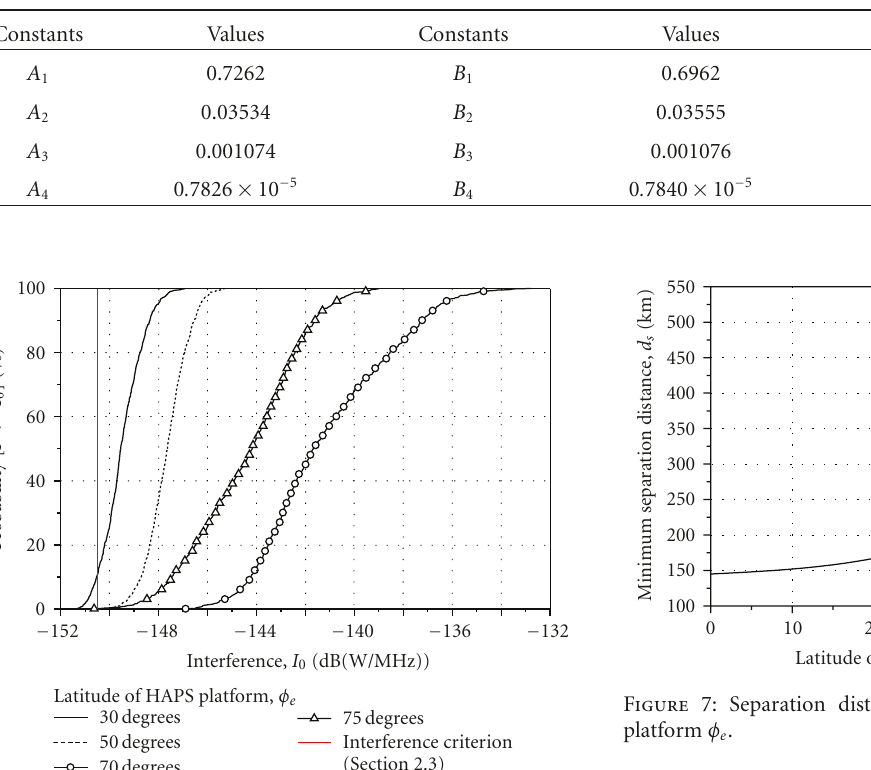
Table 3: Constant values.